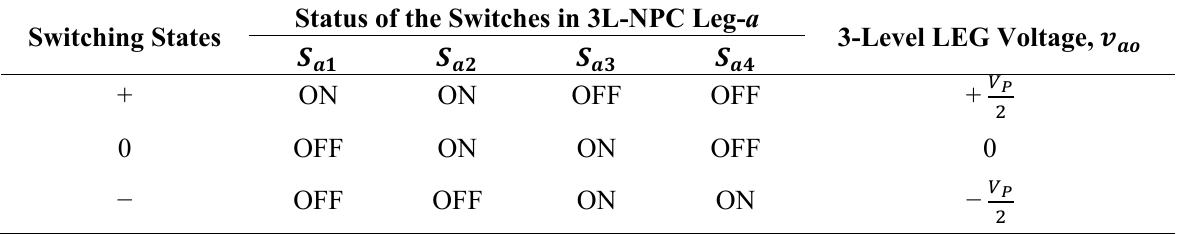
Table 1. Switching states in a 3L-NPC